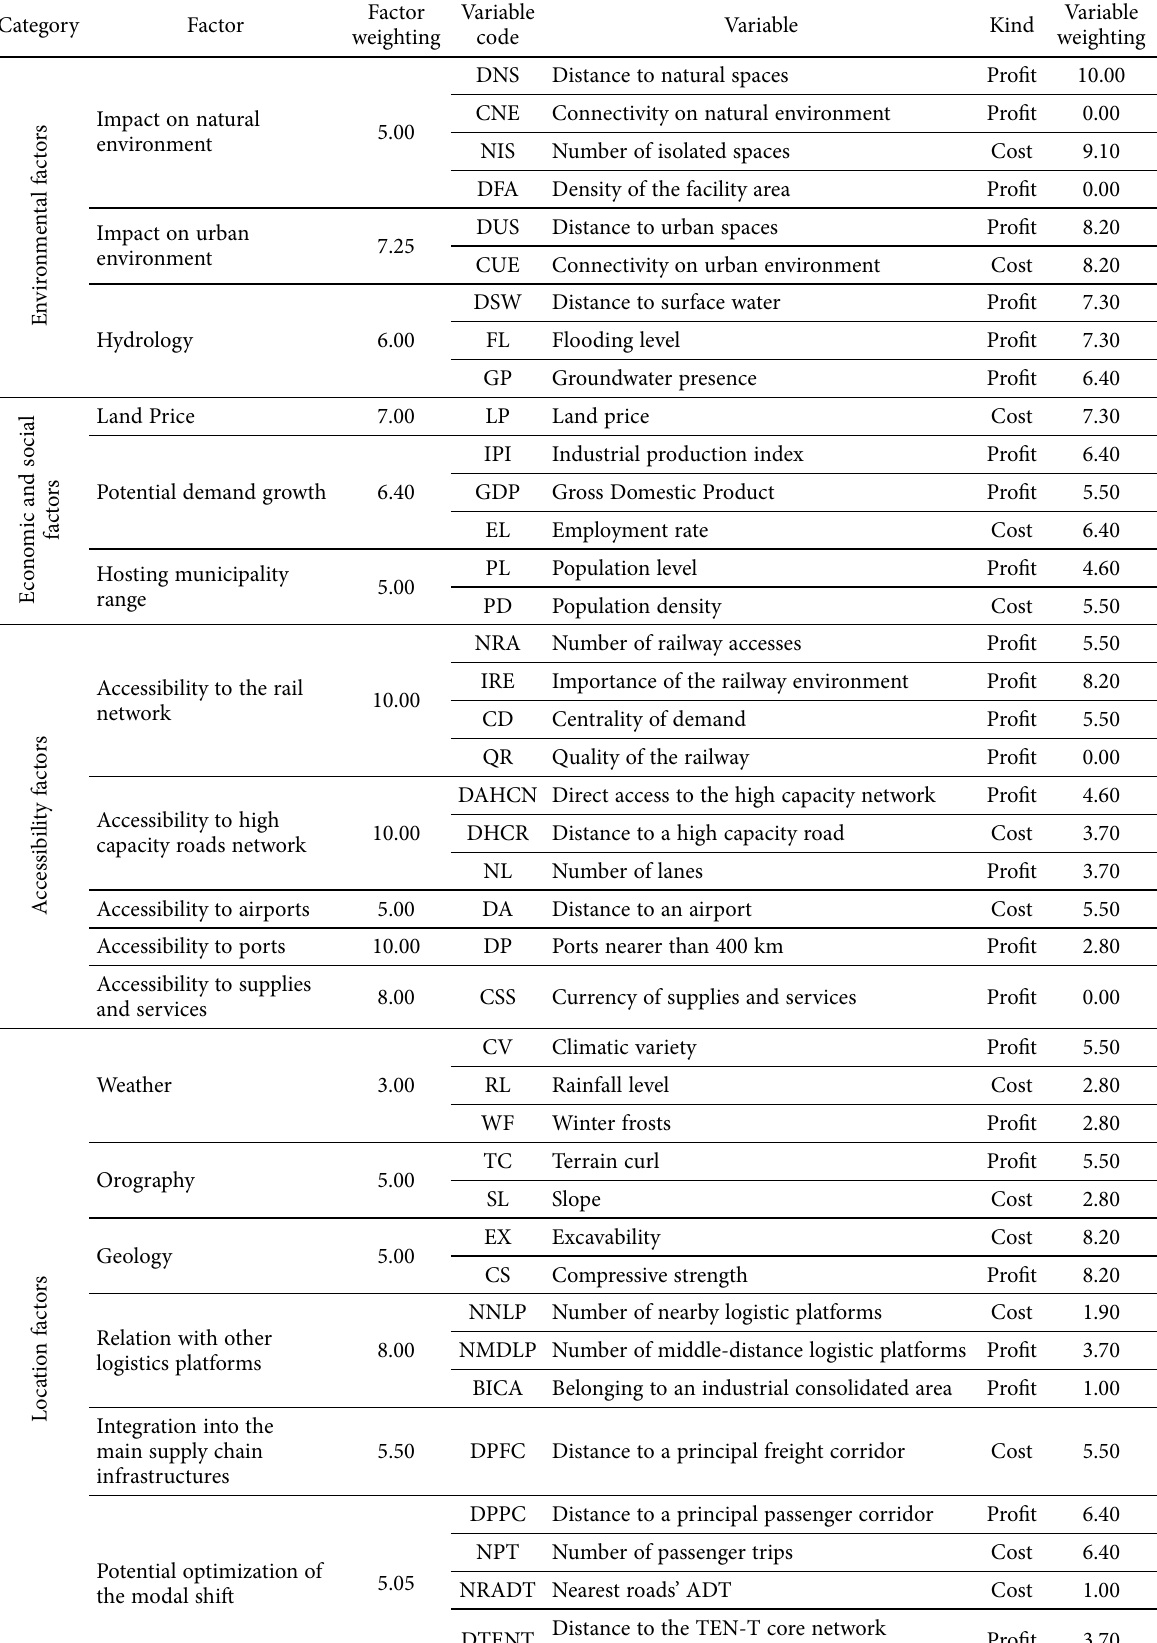
Table 1. Factors influencing the location of dry